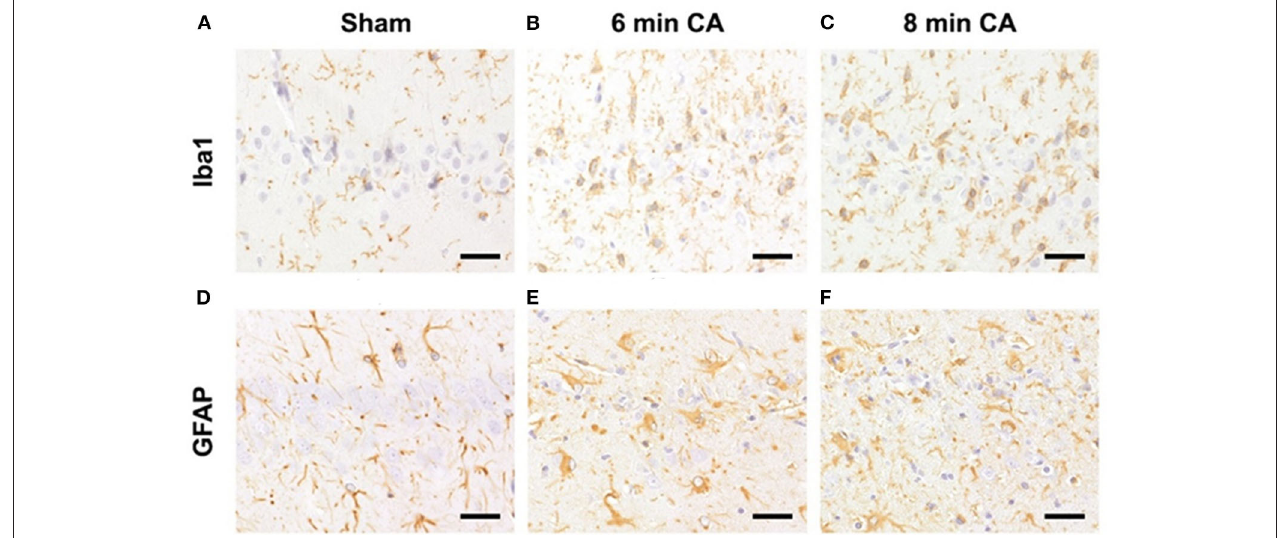
FIGURE 8 | Representative pictures of microglia and astrocyte activation after CA in the hippocampus, bar = 30 µ m. (A–C) Detection of microglia (antibody against Iba1) in the Hc. (A) Normal appearance and numbers of microglial cells in sham animal. (B,C) Increased numbers of activated microglia in CA animals. (D–F) Detection of astrocytes (antibody against GFAP) in the Hc. (D) Normal appearance and numbers of astrocytes in sham animal. (E,F) Increased numbers of gemistocytes in CA animals. CA, cardiac